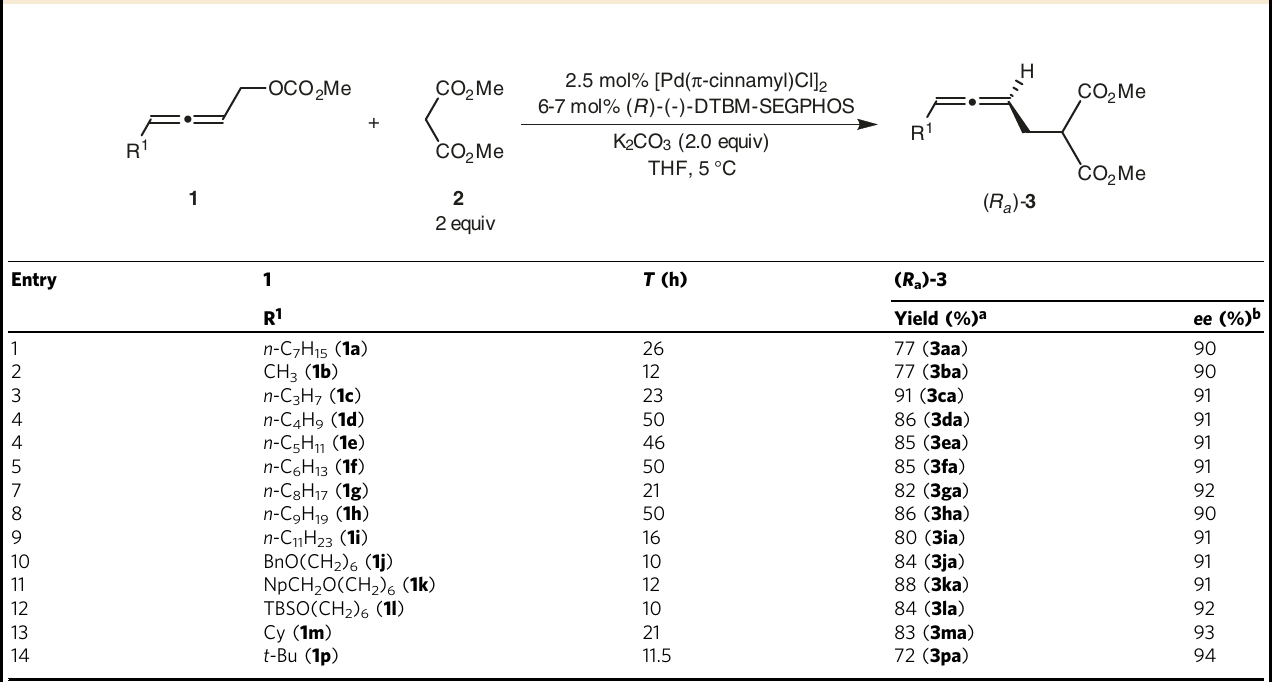
Table 2 The scope of allenylic carbonates with non-substituted dimethyl